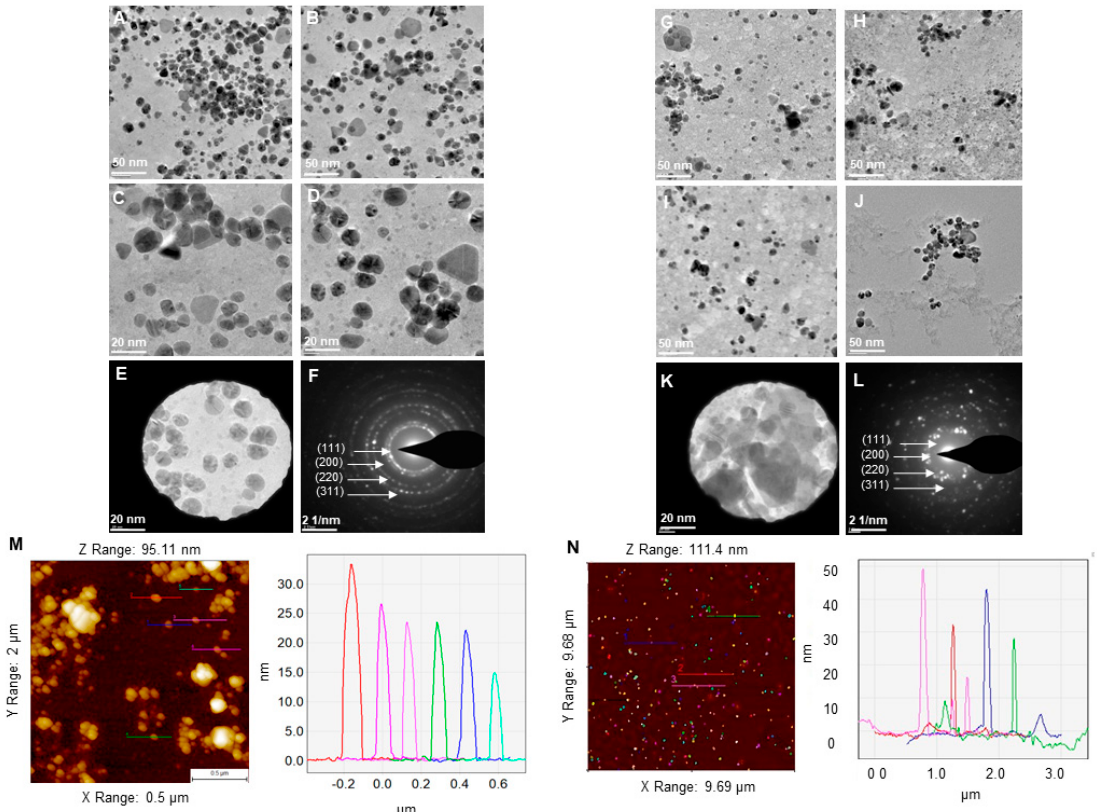
Figure 5. TEM micrographs for ( A – D ) P-AgNPs and ( G – J ) E-AgNPs. TEM micrograph with visualized SAED aperture and the corresponding SAED pattern for ( E , F ) P-AgNPs and ( K , L ) E-AgNPs. AFM analysis of ( M ) P-AgNPs and ( N ) E-AgNPs. The colored line on the individual nanoparticles resembles the size of nanoparticles in the respective graph.